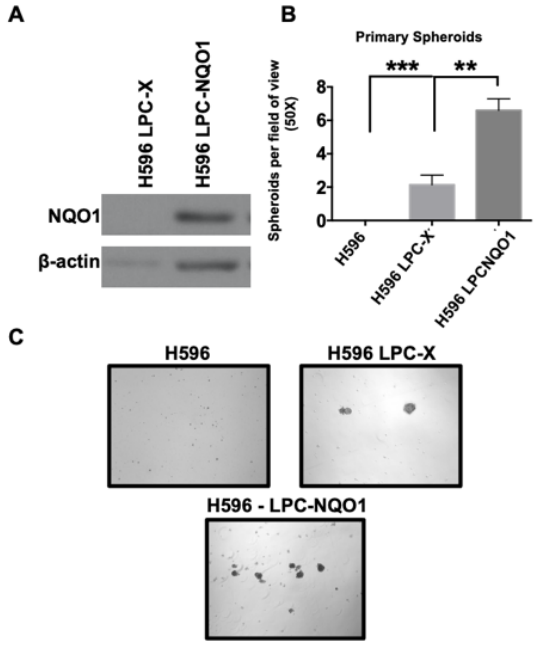
Figure 5. Overexpression of NQO1 in NQO1 null H596 cells enhances tumor spheroid formation. The NQO1-null lung cancer cell line, H596, was forced to over-express NQO1 via retroviral vector and subjected to the spheroid formation assay. NQO1 expression in the LPC-NQO1 cell line was confirmed via Western blot in ( A ). In ( B ), the numbers of spheroids formed per field of view were quantified in the parental, LPC-X, and LPC-NQO1 H596 cell lines. ( C ) shows representative images corresponding to the quantification found in B (*** = p = 0.0007; ** = p = 0.0078). Table 1. Cancer stem cell frequency in A549 and H358 cells with or without shNQO1 expression . Quantification of the number of cancer stem cells present in the examined cell populations was car- ried out utilizing an in vitro extreme limited dilution assay. The assay required plating limited di- lutions of cells in low attachment conditions and examining wells for spheroid formation. Wells with at least one spheroid were counted as a positive well for the corresponding dilution. The results were then analyzed using Extreme Limited Dilution Analysis (ELDA) software. The resulting CSC frequencies demonstrate a marked increase in the CSC population found in A549-shCtr and H358- shCtr in comparison to their respective shNQO1 cell lines.